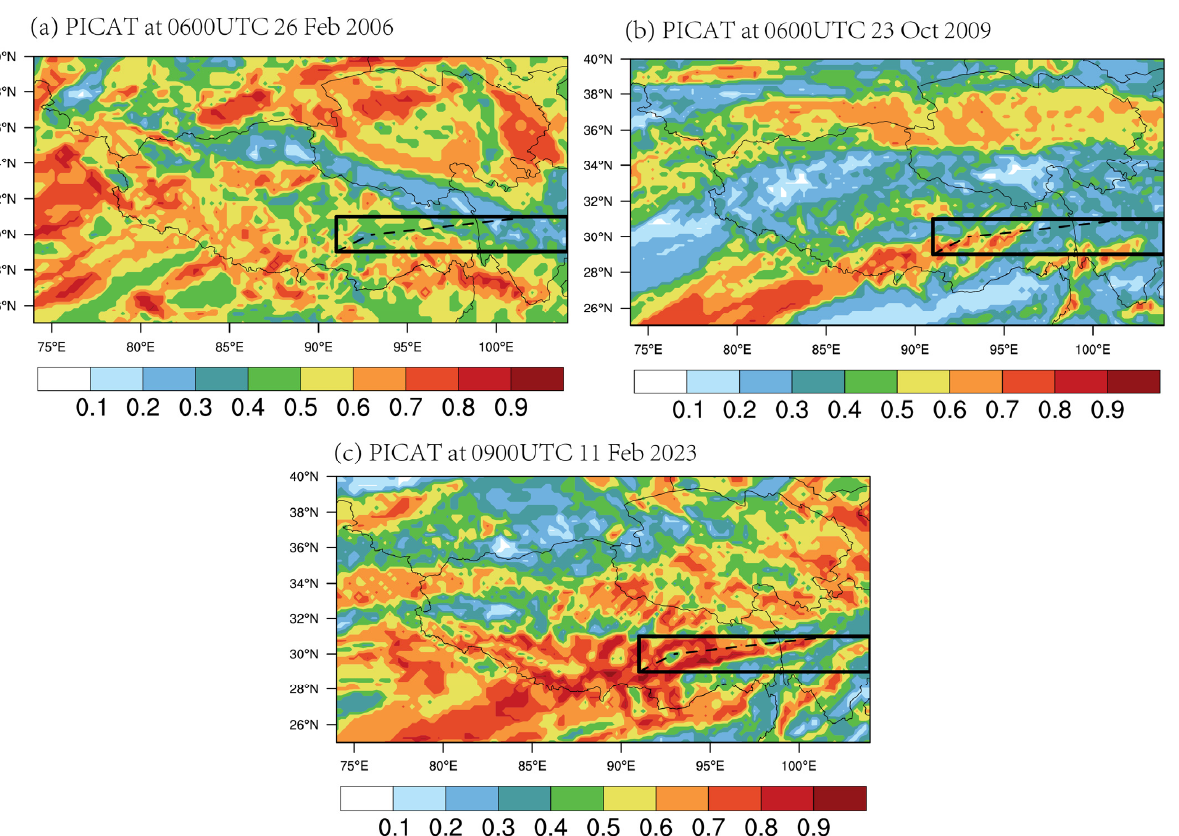
Figure 4. PICAT for the intensity of light or greater at 200 hPa at ( a ) 0600 UTC on 26 February 2006, ( b ) 0600 UTC on 13 October 2009, and ( c ) 0900 UTC on 11 February 2023. The black squares represent the range of the Chengdu–Lhasa route.